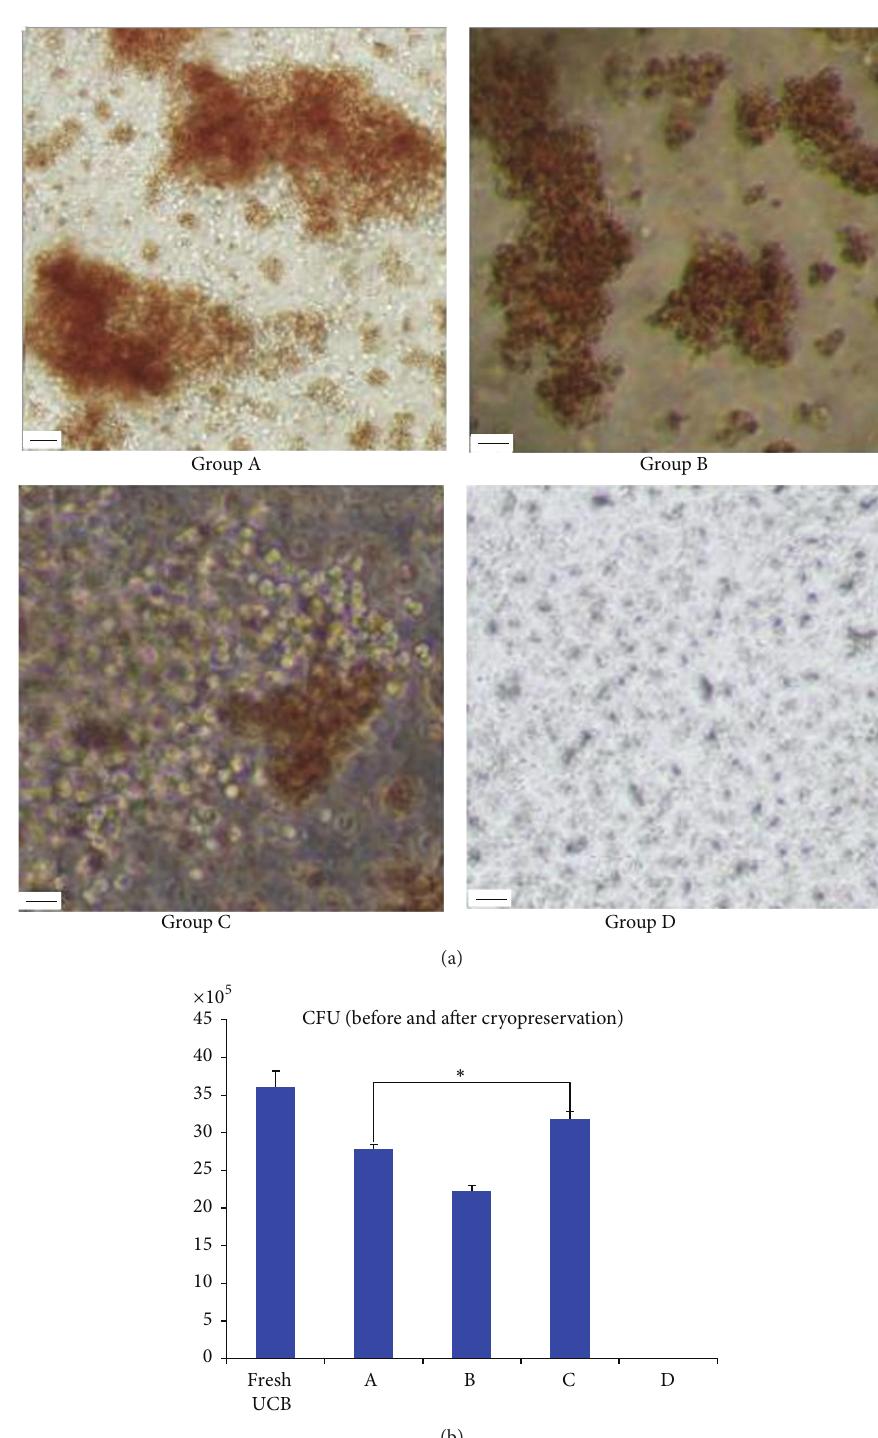
Figure 3: (a) The colonies were observed in an inverted microscope. CFU-GEMM is full of the immature nucleated red blood cells and granulocytes from the center to the edge of clone and two CFUs of GEMM were showed in group A. BFU-E are red and were shown in group B. CFU-GM is almost transparent and BFU-E and CFU-GM were shown in group C. There was almost no colony formation in group D. (b) The CFU of group C was higher than that of group A ( 𝑃 < 0.05 ) and groups B, D ( 𝑃 < 0.01 ) after thawing. Scale bars: 100 𝜇